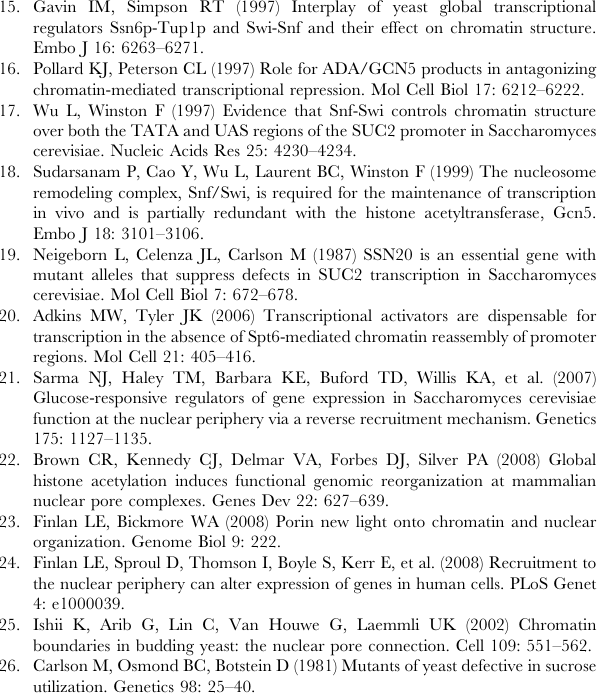
Figure S1 Nup84-lexA fusions localize to the nuclear periphery. Left panel shows confocal images of cells containing yellow fluorescent protein (YFP) fused to the C-terminus of lexA- tagged nucleoporin Nup84. The fusion proteins localize at the nuclear periphery, and are thus observed as distinct rings. Right